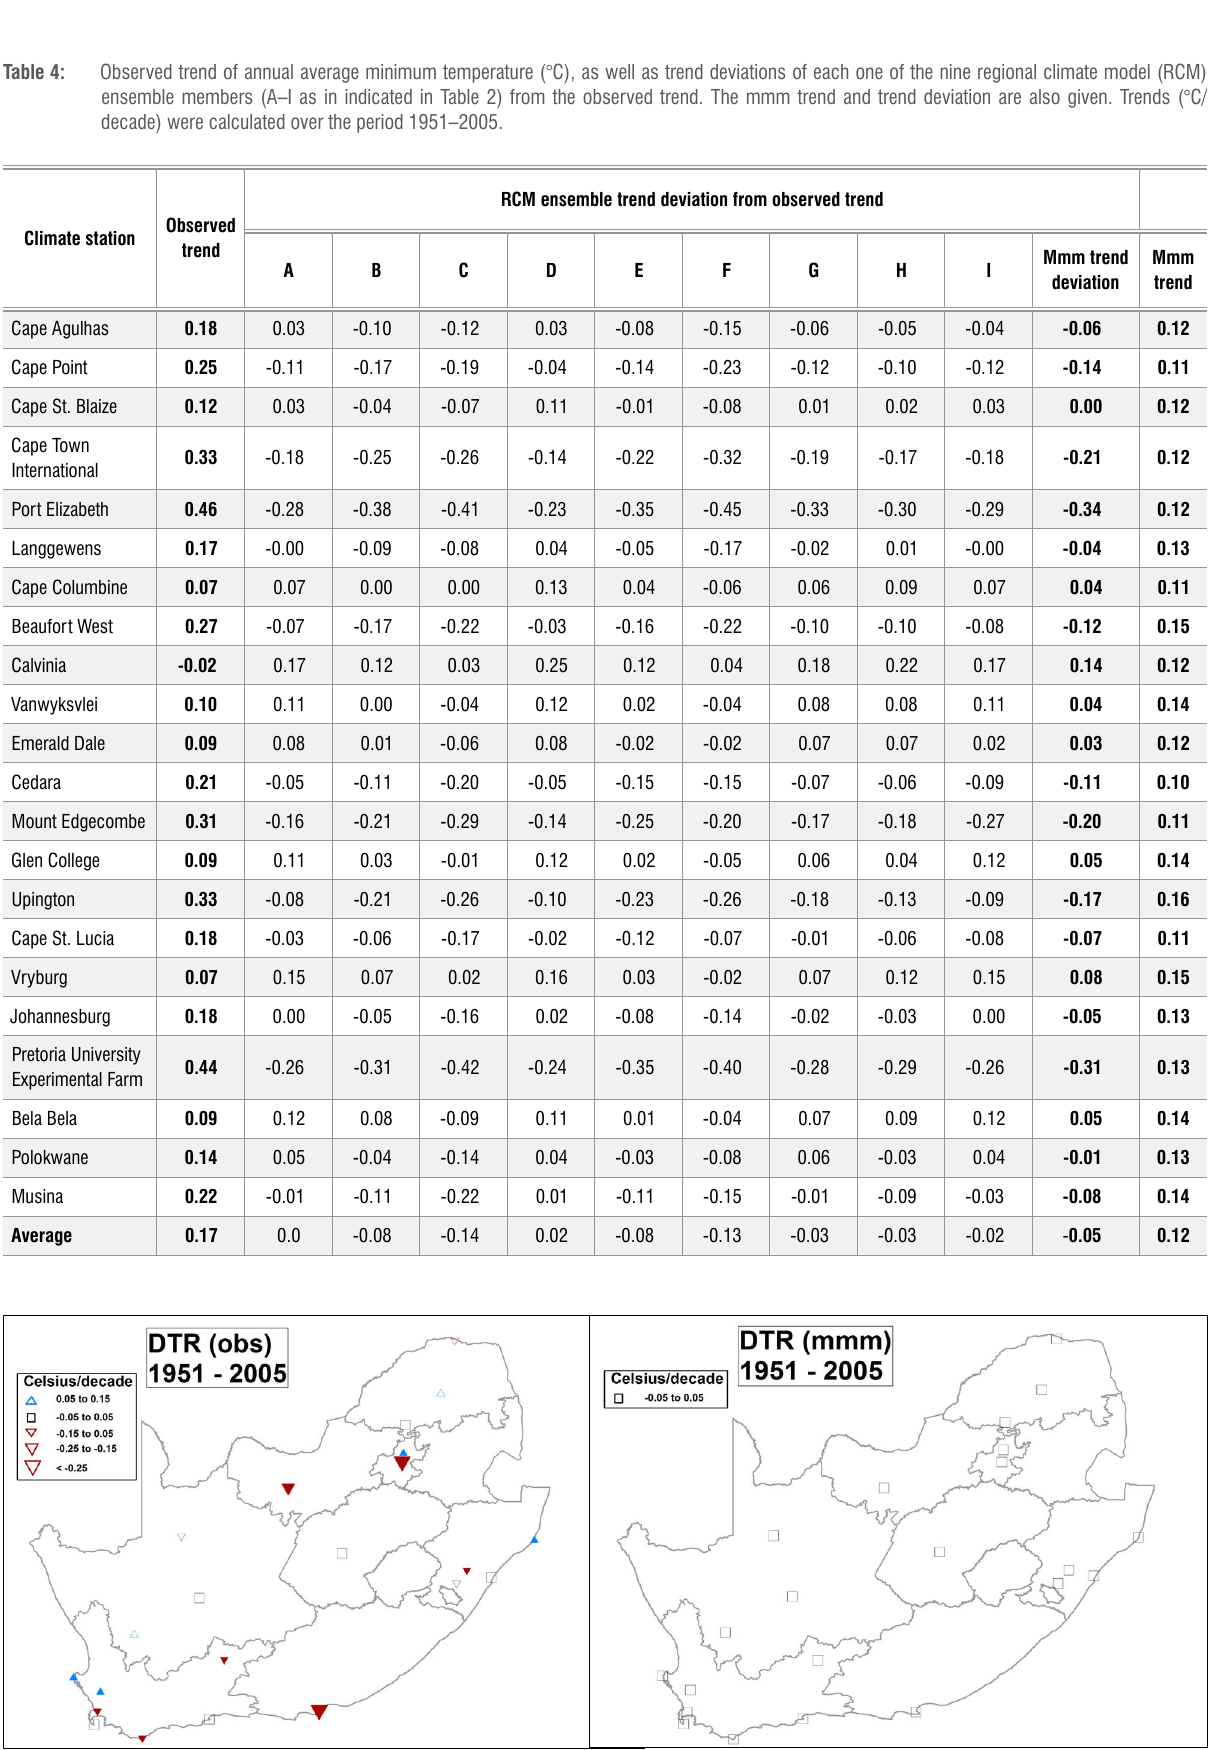
Figure 2: Trends in annual mean diurnal temperature range (DTR) in °C per decade, for the period 1951–2005, from the observations (obs) and multi-model mean (mmm) data sets, as indicated. Filled triangles denote significant trends at the 5%